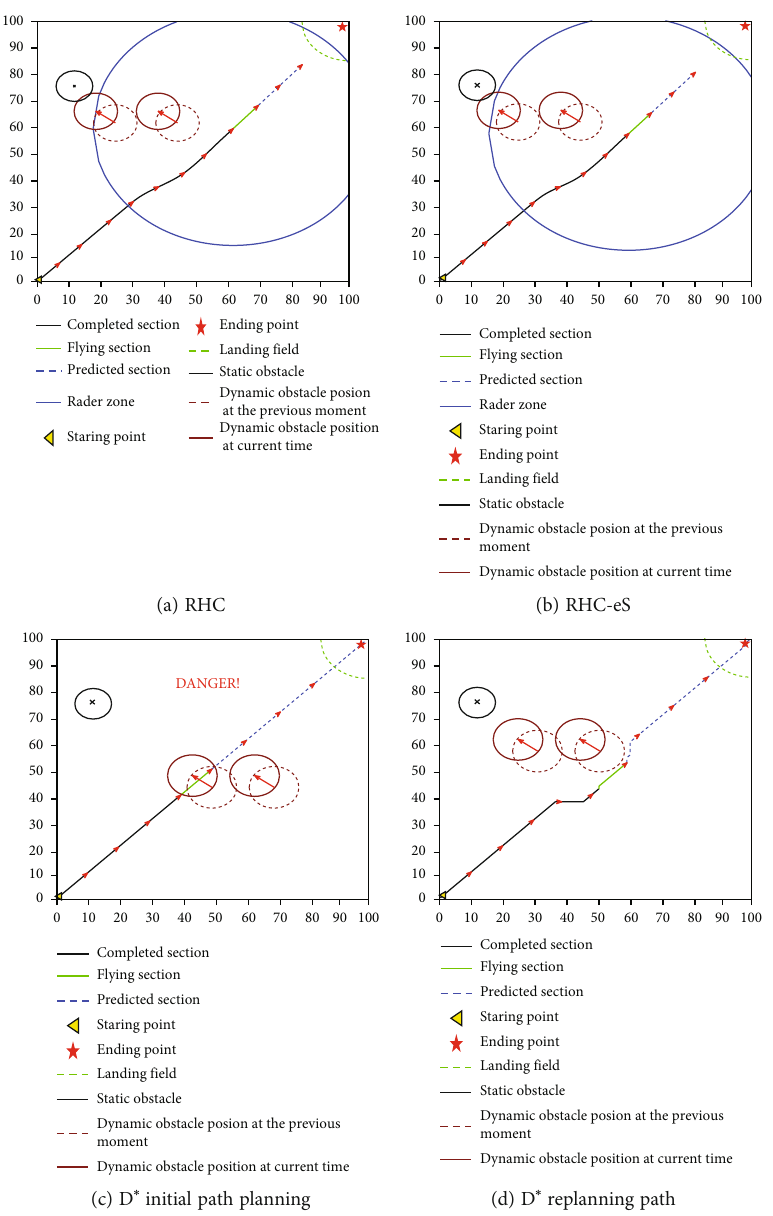
Figure 5: Environmental case 1 path planning green dotted line circle, respectively. The gray circle is a static obstacle. The previous time position and current time position of the known dynamic obstacle are represented by a red dotted line circle and a solid line circle, respectively. Unknown dynamic threats are represented by purple red circles. The black solid line, green solid line, and blue dotted line are used to represent the fl own section, fl ying section, and future pre- dicted section, respectively. The red arrow on the map indi- cates the direction of movement.